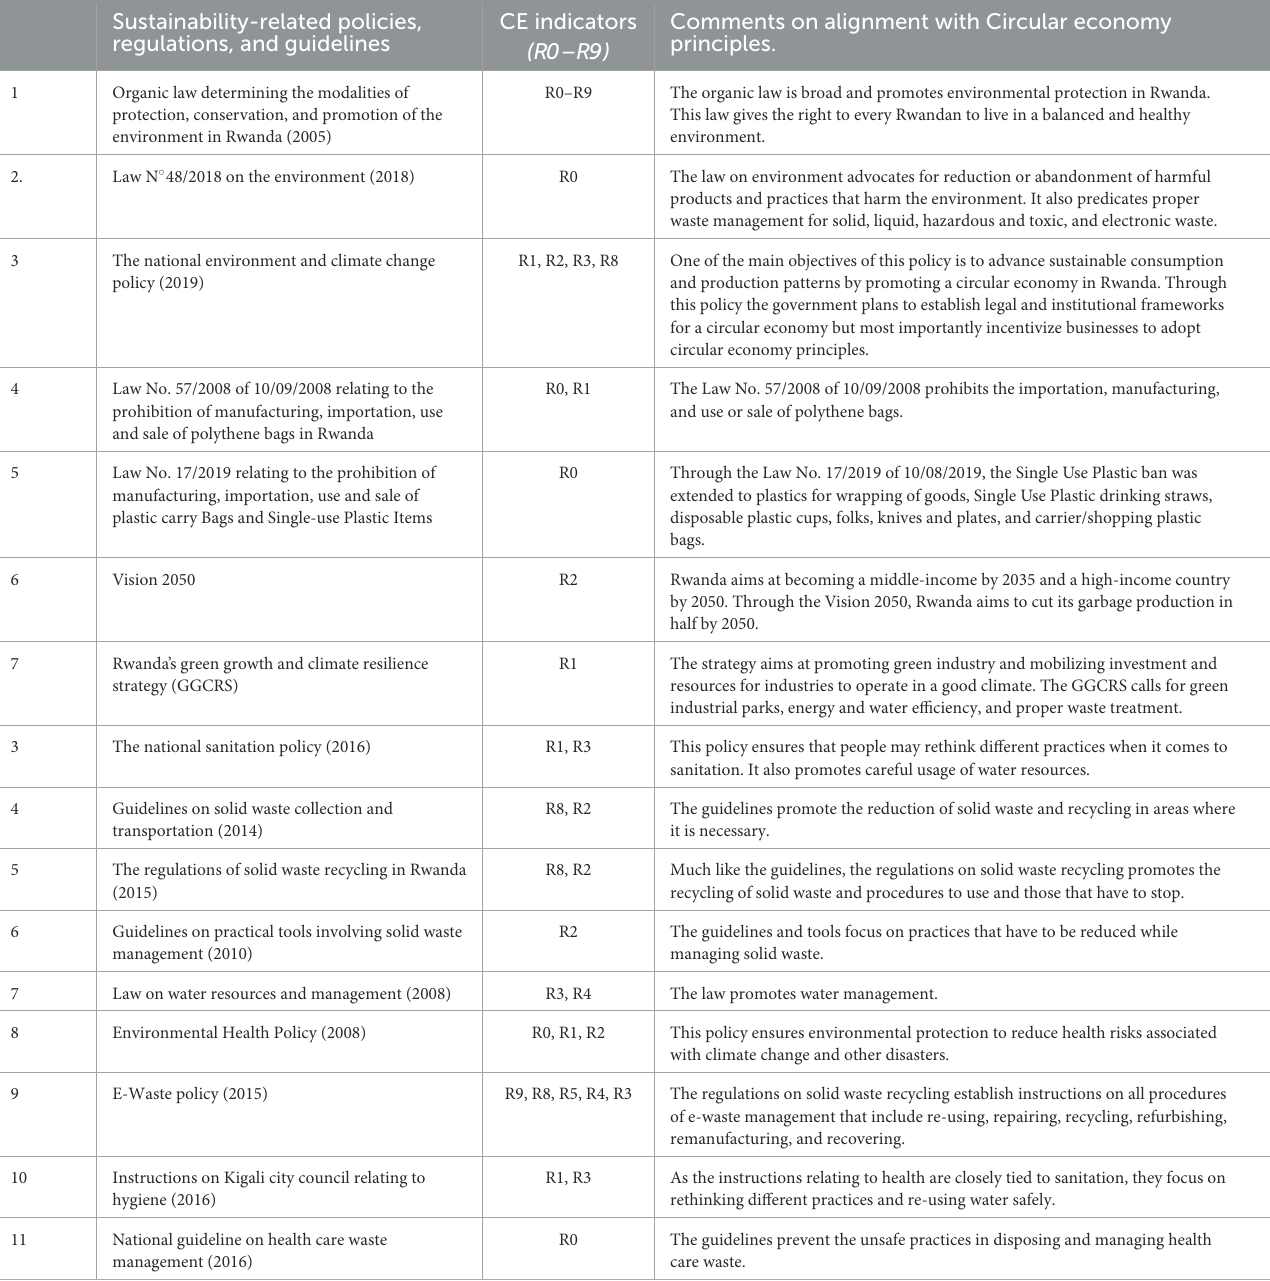
TABLE 7 How sustainability policies in Rwanda align with the 10-R principles of circular economy. Sustainability-related policies, regulations, and guidelines